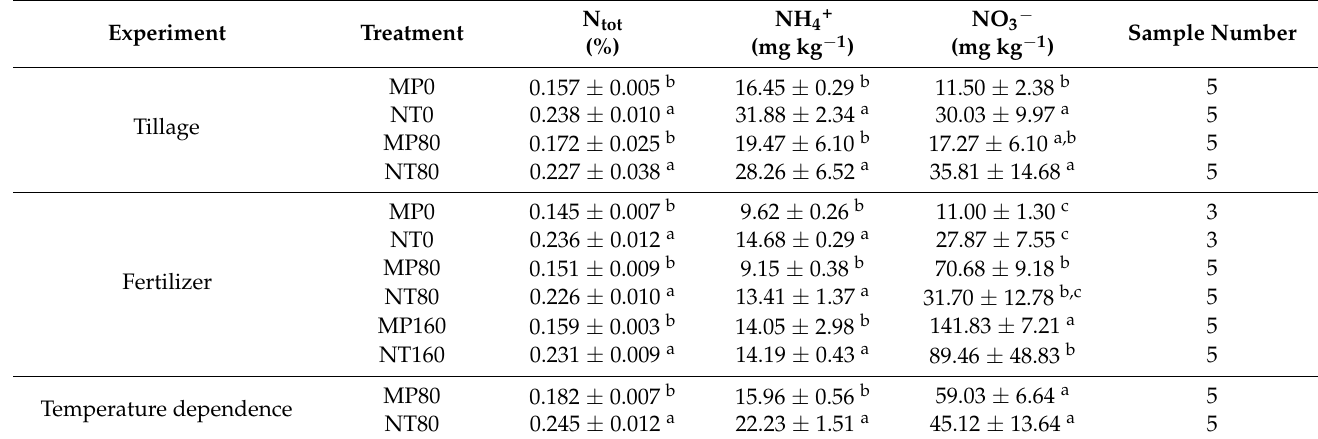
Table 9. Soil chemical parameters of the laboratory